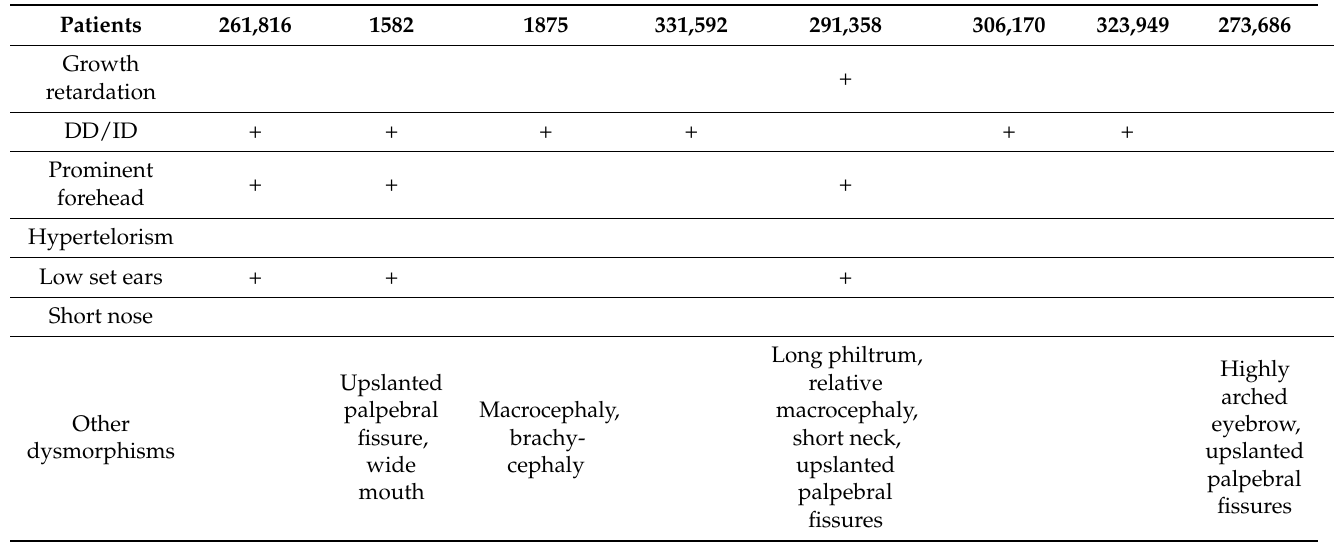
Table 3. Clinical data of 12q21 deleted patients from the DECIPHER